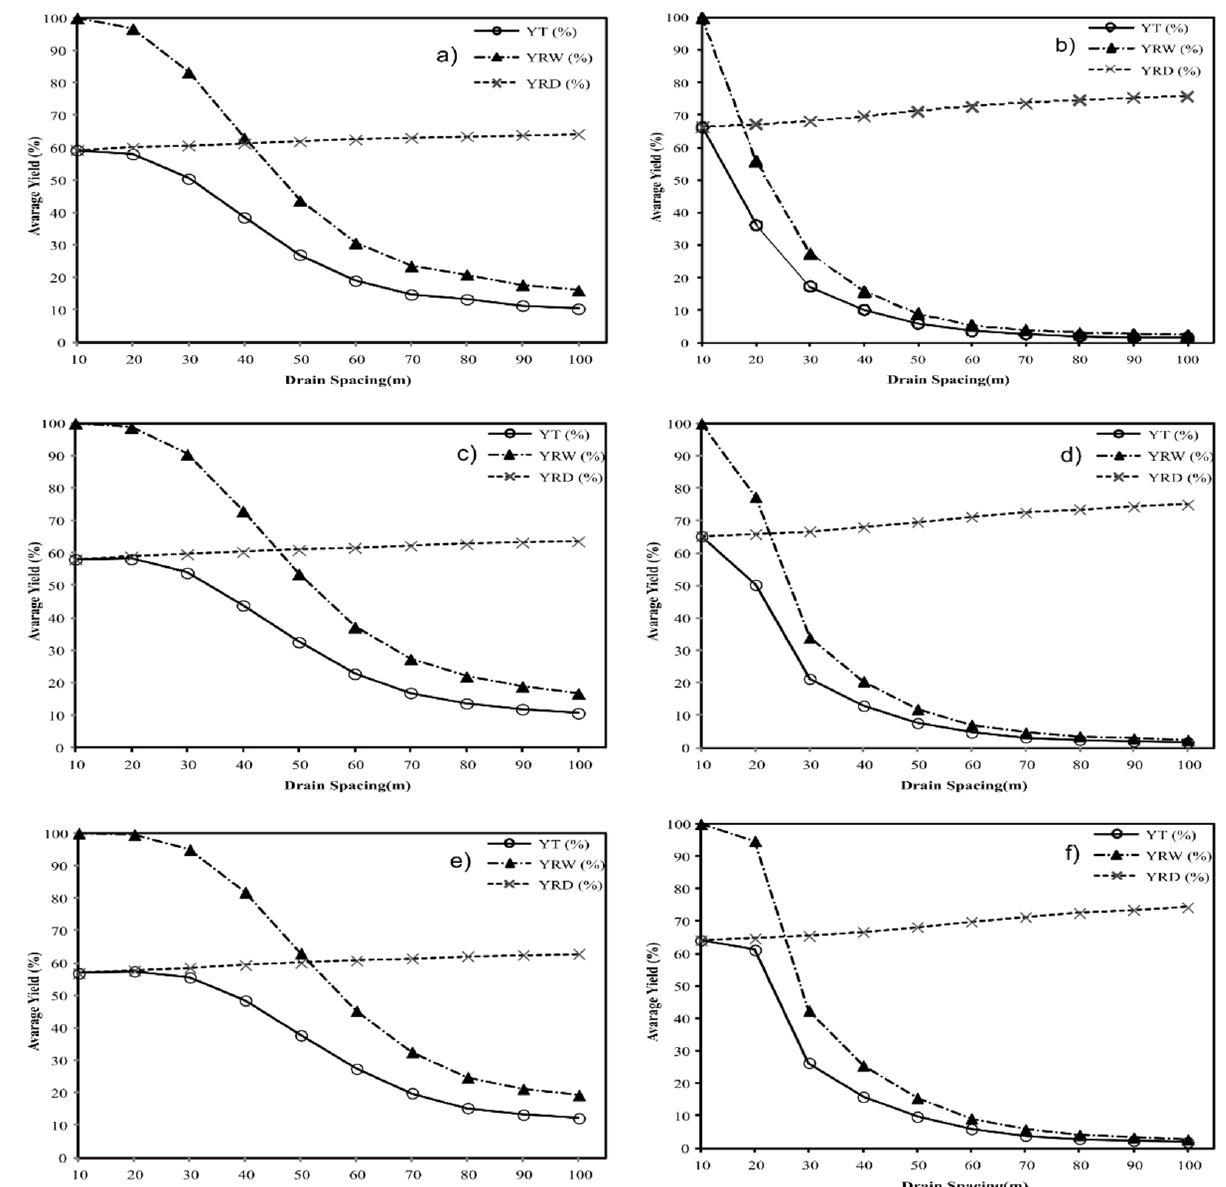
Figure 5. Yield due to excess water (YRW), deficit (YRD) and total (YT) for sugarcane in the period of 1972–2012, for soil 1 for drain spaces varying from10 to 100 m and drain depths of 1.2 ( a , b ), 1.4 ( c , d ) and 1.6 ( e , f ) m for the Barinas ( a , c , e ) and Turen ( b , d , f ) weather stations.